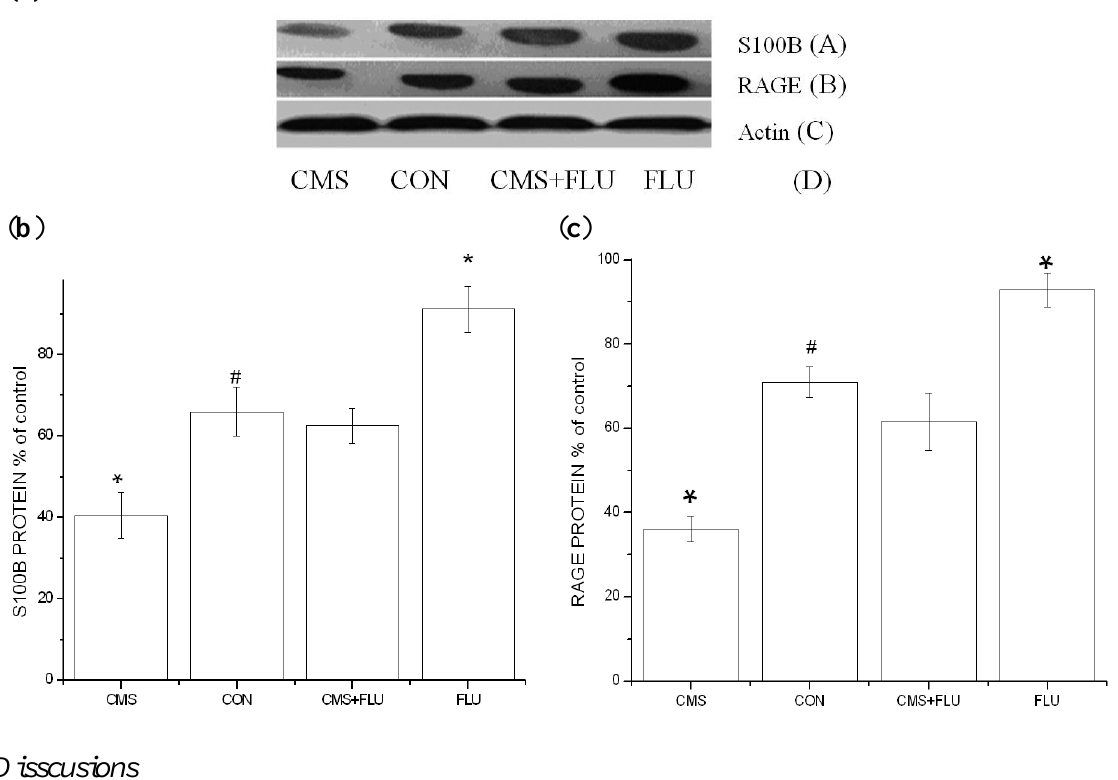
Figure 3. Representative Western blot bands and densitometric analyses of the bands of S100B and RAGE in the hippocampus. Results are expressed as mean ±